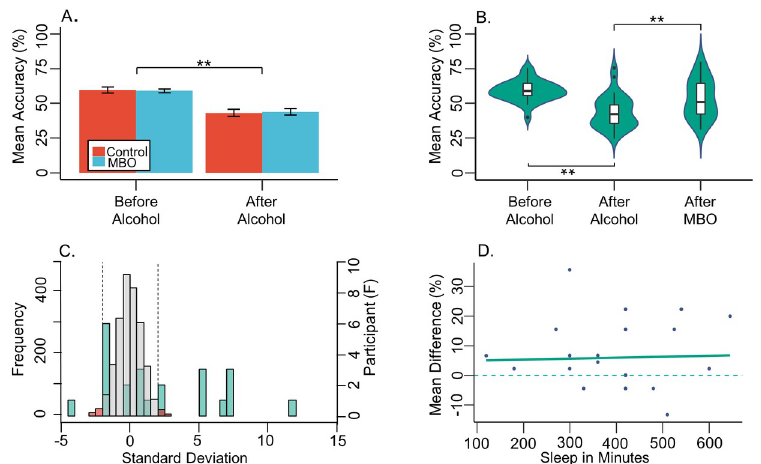
Fig 2. Free recall. ( A ) bar graph shows between control and MBO group mean accuracy (%) of freely recalled words, both before and after ingesting alcohol. Error bars depict standard mean error with �� denoting significance at p < .01, and � < .05. ( B ) violin plots displaying the distribution of MBO participant responses, with embedded box and whisker plots across all three test conditions ( before-alcohol , after-alcohol , after-MBO ). Outliers appear as dots above or below the box and whisker plots. Note the change in spread of the distribution for the after-MBO condition in comparison to before and after-alcohol conditions. ( C ) histograms depicting the resampling analysis for the free recall task in the MBO group. The left y axis shows the frequency of resampled mean differences, converted into z-scores, between before-alcohol minus after-MBO conditions. Bar width is 0.5 standard deviations. Grey bars depict roughly 95% of the resampled distribution, and the red bars show the 2.5% tails at either side, demarcated by vertical dashed lines. Overlaid green bars are a separate histogram (right y axis) showing the frequency of participants’ mean differences (z- scores), with the same bar width of 0.5 standard deviations. Therefore, the figure displays how many participants are significantly different from our resampled distribution of mean differences, as these participants would be outside of the grey area on the resampled histogram. ( D ) scatterplot displays the difference between the mean accuracy (%) for freely recalled words before-alcohol minus after-MBO , correlated with reported minutes slept, within the MBO group.